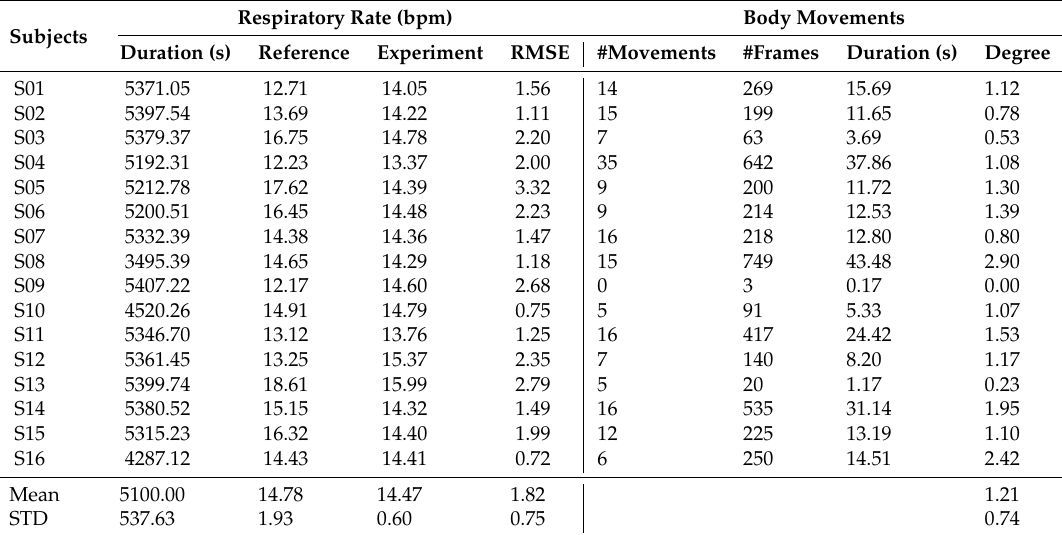
Table 3. The result of respiratory rate estimation and body movements